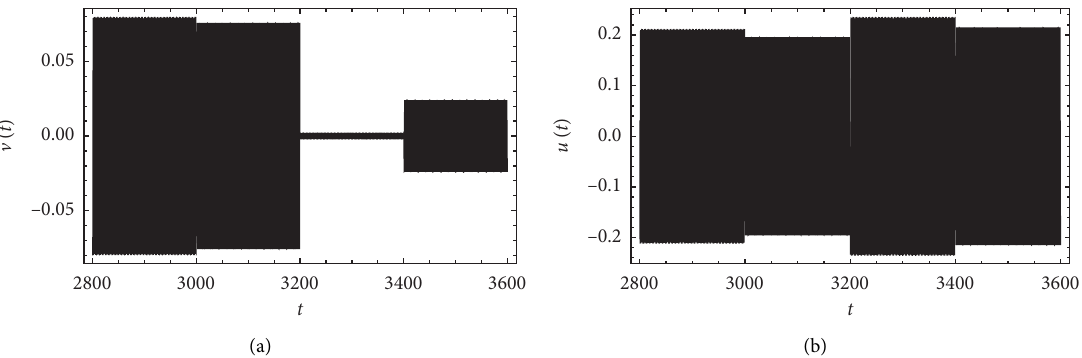
Figure 16: Time history for the controlled system when τ 3000 ≤ t ≤ 3200 , ζ � 0 . 05 , Ω � 3 . 31 , ω (a) the main system; (b) the